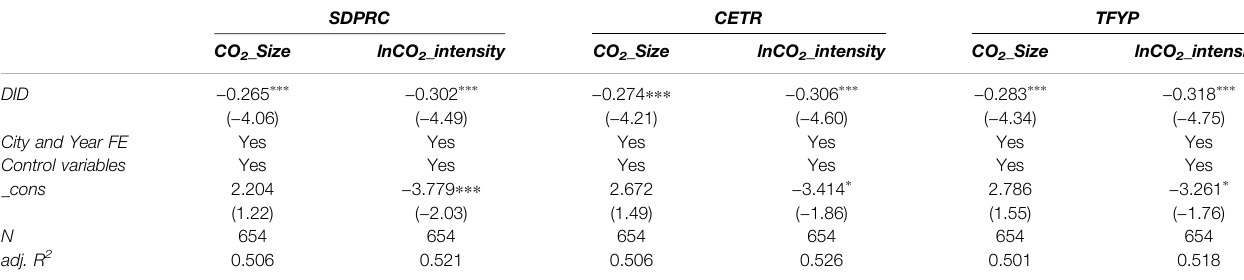
TABLE 9 | Excluding the impact of other policies.